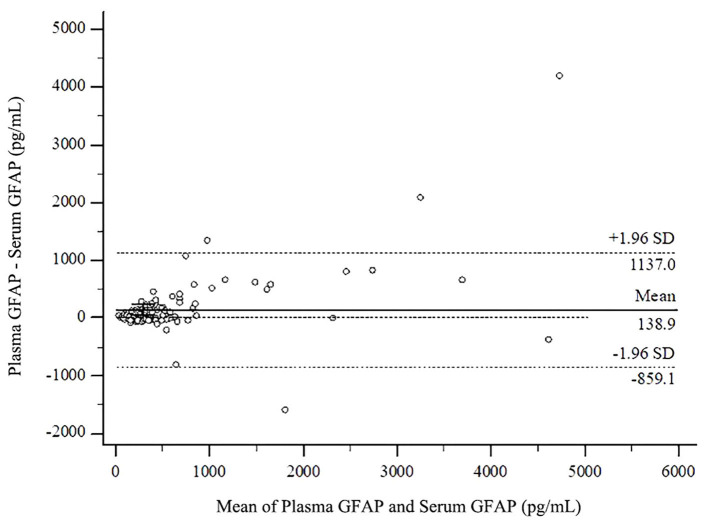
Bland-Altman plot comparing plasma and serum values in the total sample. GFAP, glial fibrillary acidic protein.